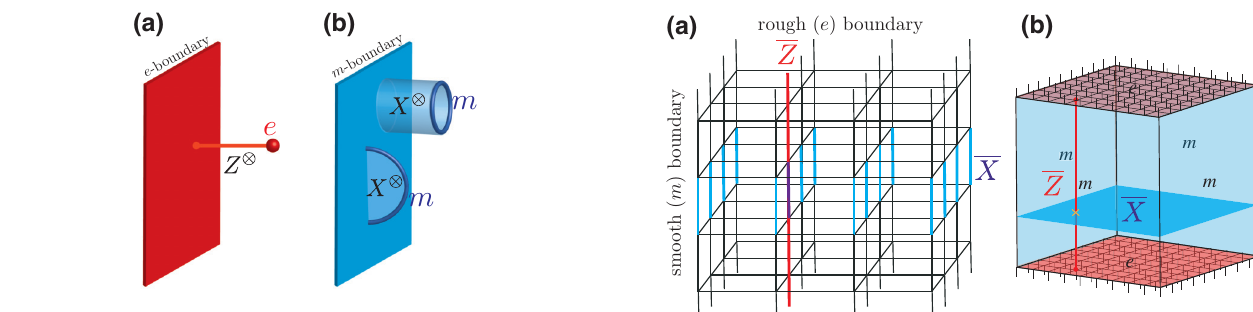
FIG. 13. (a) An e -particle excitation can condense on the e -boundary when applying a Wilson-line operator W e , which cor- responds to a Z -string operator Z ⊗ in the 3D toric code. (b) An m -string excitation can condense on the m -boundary when applying a Wilson-sheet operator W m , which corresponds to an X -brane operator X ⊗ in the 3D toric code.